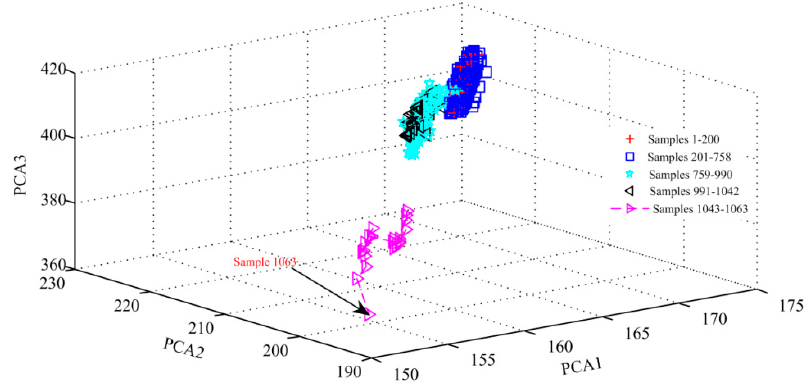
Figure 6. Spatial distribution of all samples when using the first three principal components.